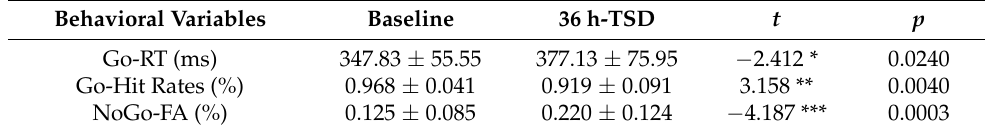
Table 1. Means and standard deviations of reaction times (RT) and hit rates in Go trials and false alarms (FA) in NoGo trials at baseline and 36-h total sleep deprivation (TSD) and t -test results. Behavioral Variables Baseline 36 h-TSD t p Go-RT (ms)